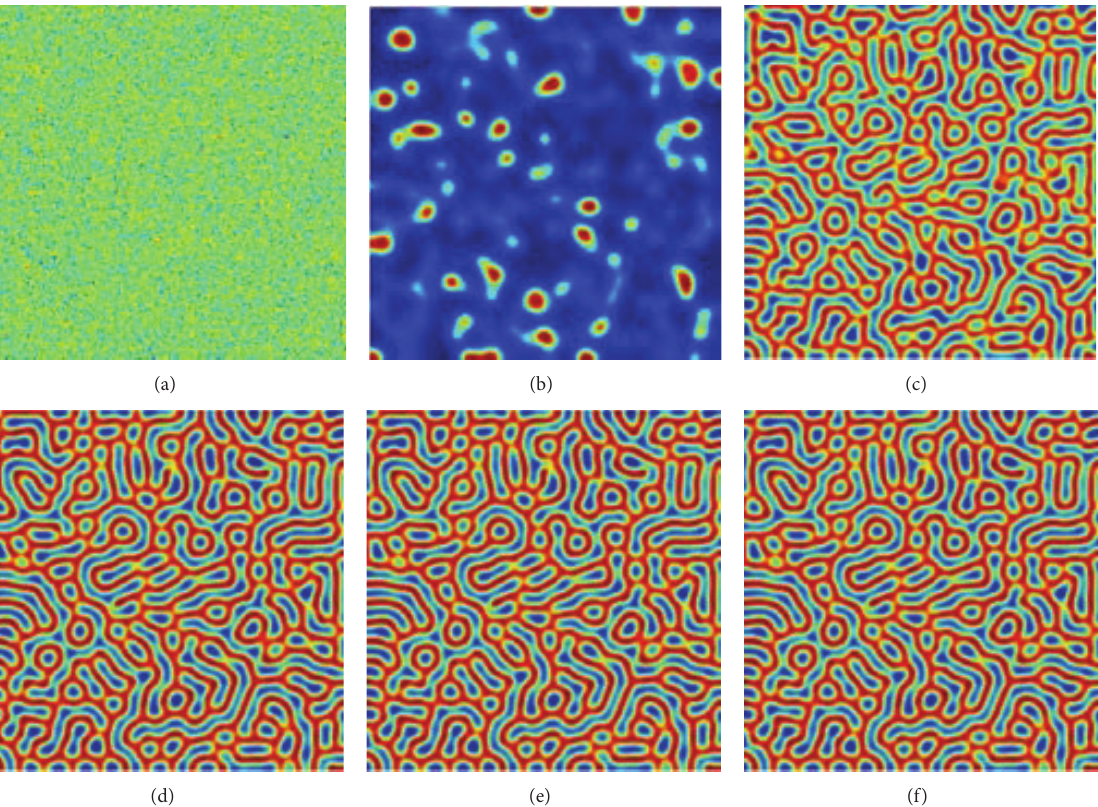
Figure 5: Spatial pattern of prey population at different time. Parameters set: 𝛾 = 1.5 , 𝜀 = 0.15 , and 𝛿 = 1 . (a) 𝑡 = 0 ; (b) 𝑡 = 150 ; (c) 𝑡 = 300 ; (d) 𝑡 = 500 ; (e) 𝑡 = 600 ; and (f) 𝑡 = 1000